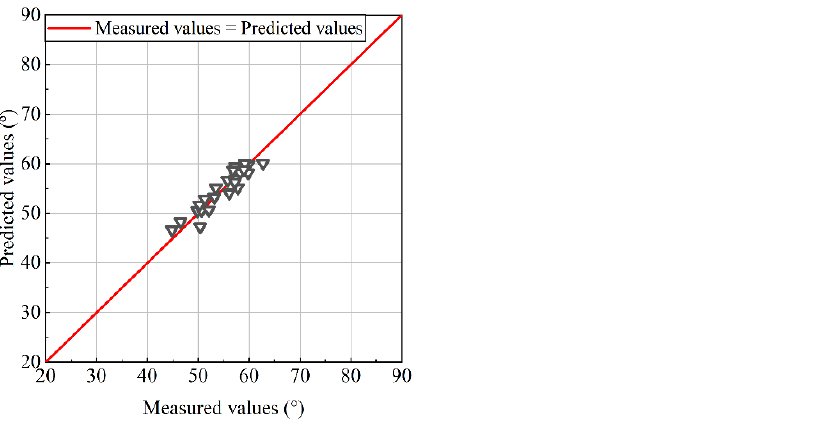
Figure 13. Measured and predicted values of the internal friction angle of CGS.